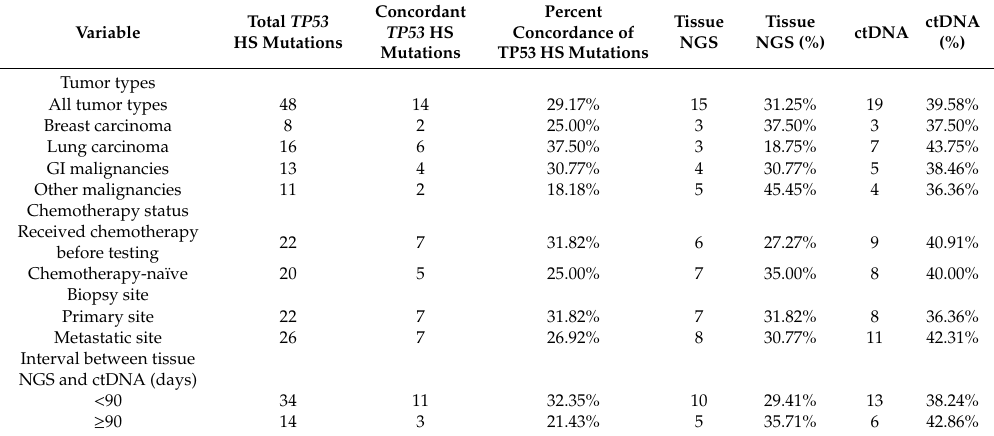
Table 3. TP53 hotspots (HS) mutation concordance based on tumor types, systemic therapy status, biopsy site and interval between tissue NGS and